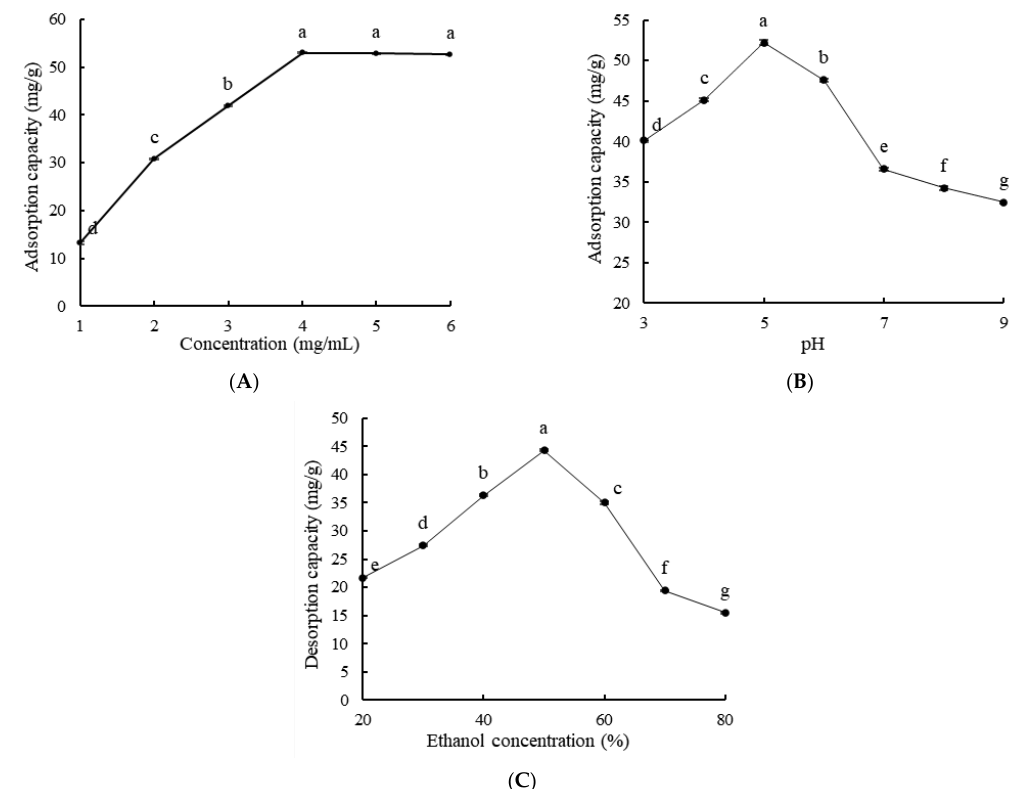
Figure 4. Effects of sample concentration ( A ), sample pH ( B ), and ethanol concentration ( C ) on the adsorption and desorption capacity of LSA-900C macroporous resin. Lowercase letters indicate sig- nificant differences ( p <